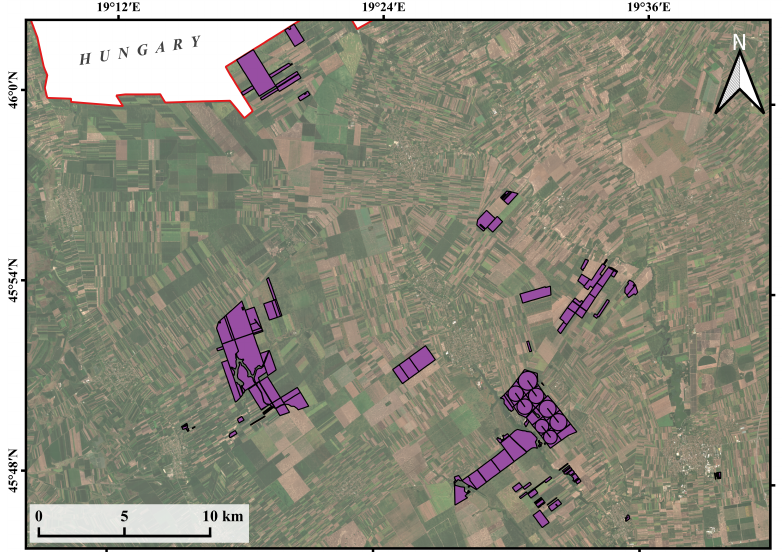
Figure 2. Location of the parcels with maize and sunflower yield provided by the agricultural com-